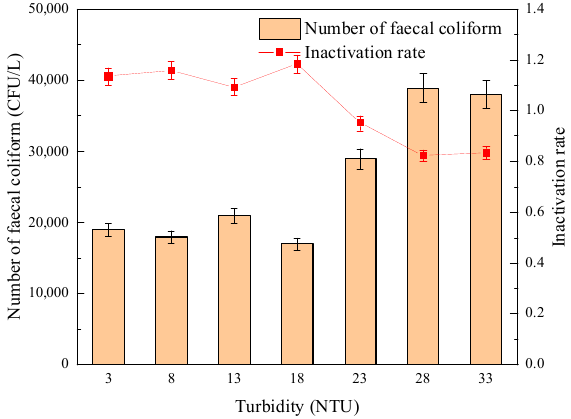
Figure 13. Effect of turbidity on the sterilization effect of “Method B”.